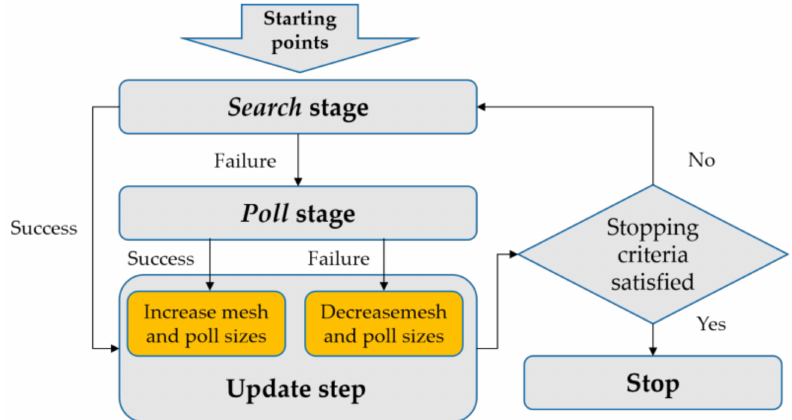
Figure 2. Illustration of the mesh adaptive direct search (MADS)